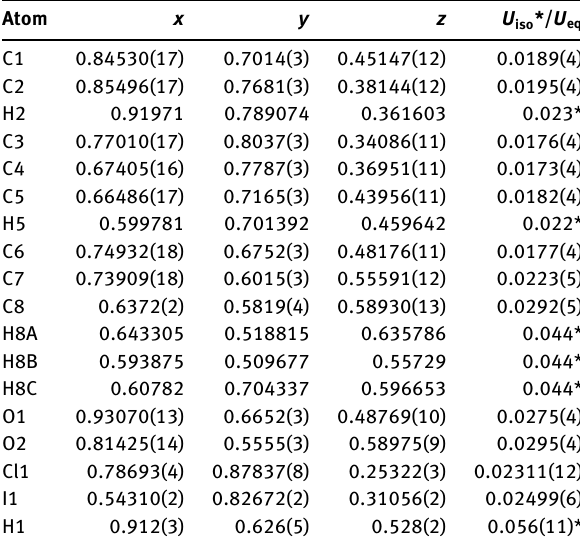
Table 2: Fractional atomic coordinates and isotropic or equivalent isotropic displacement parameters (Å 2